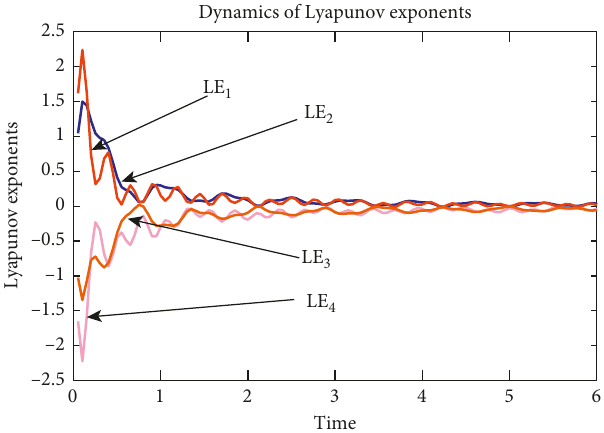
Figure 2: Lyapunov exponents of chaotic system (6) vs. t .